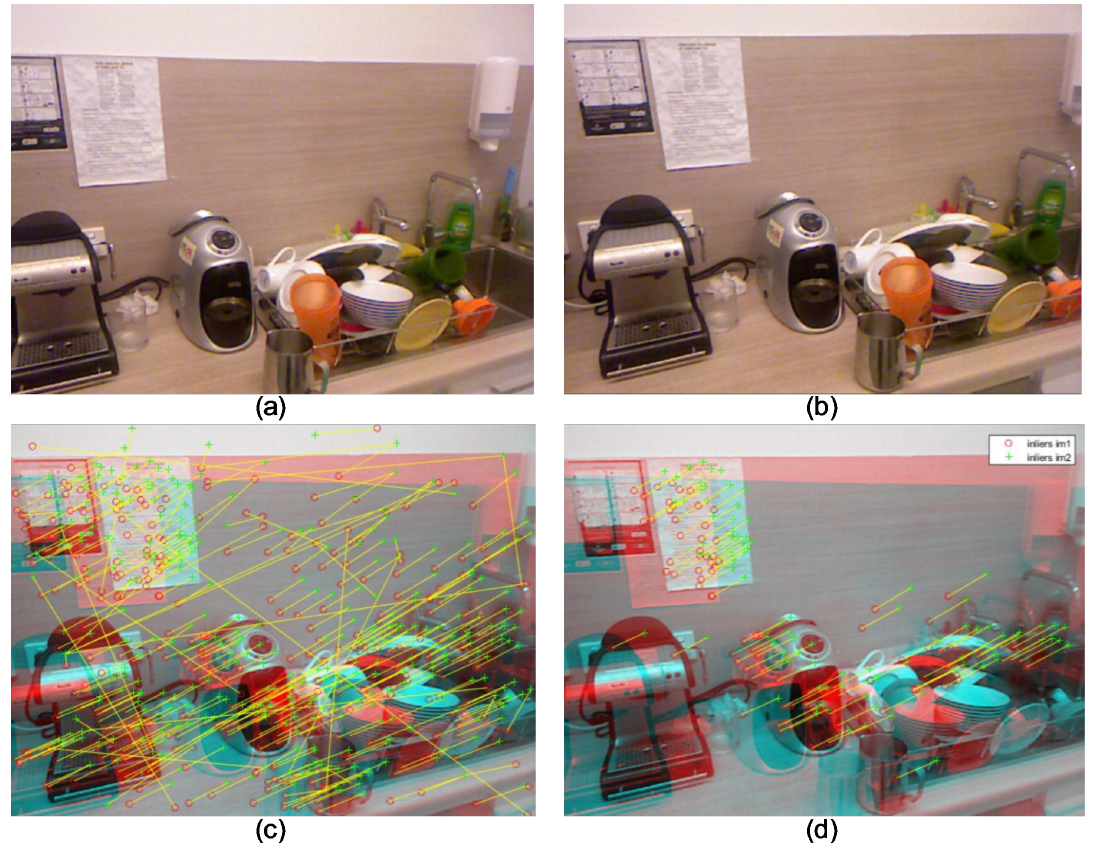
Figure 2. Feature extraction using ORB on two frames. ( a ) An RGB image from the first frame; ( b ) an RGB image from the second frame; ( c ) feature matching result using ORB descriptors and ( d ) feature matching refined using